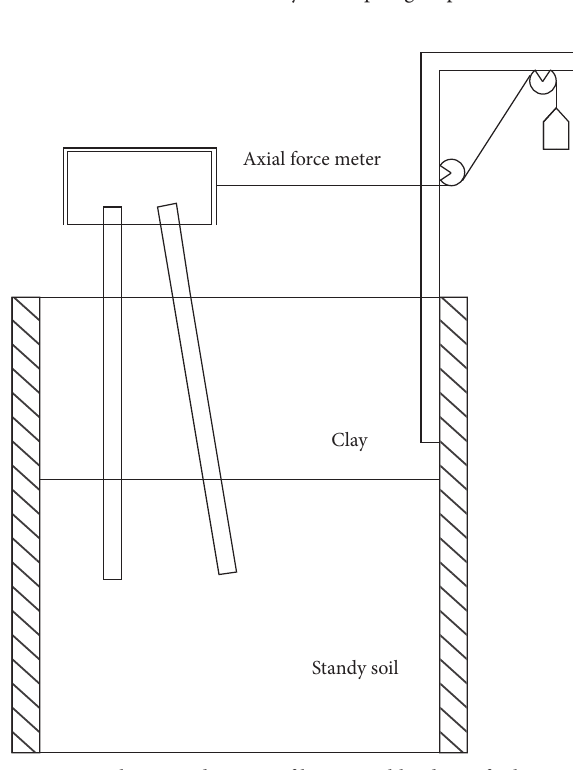
Figure 12: Schematic diagram of horizontal loading of pile groups with low pile caps.